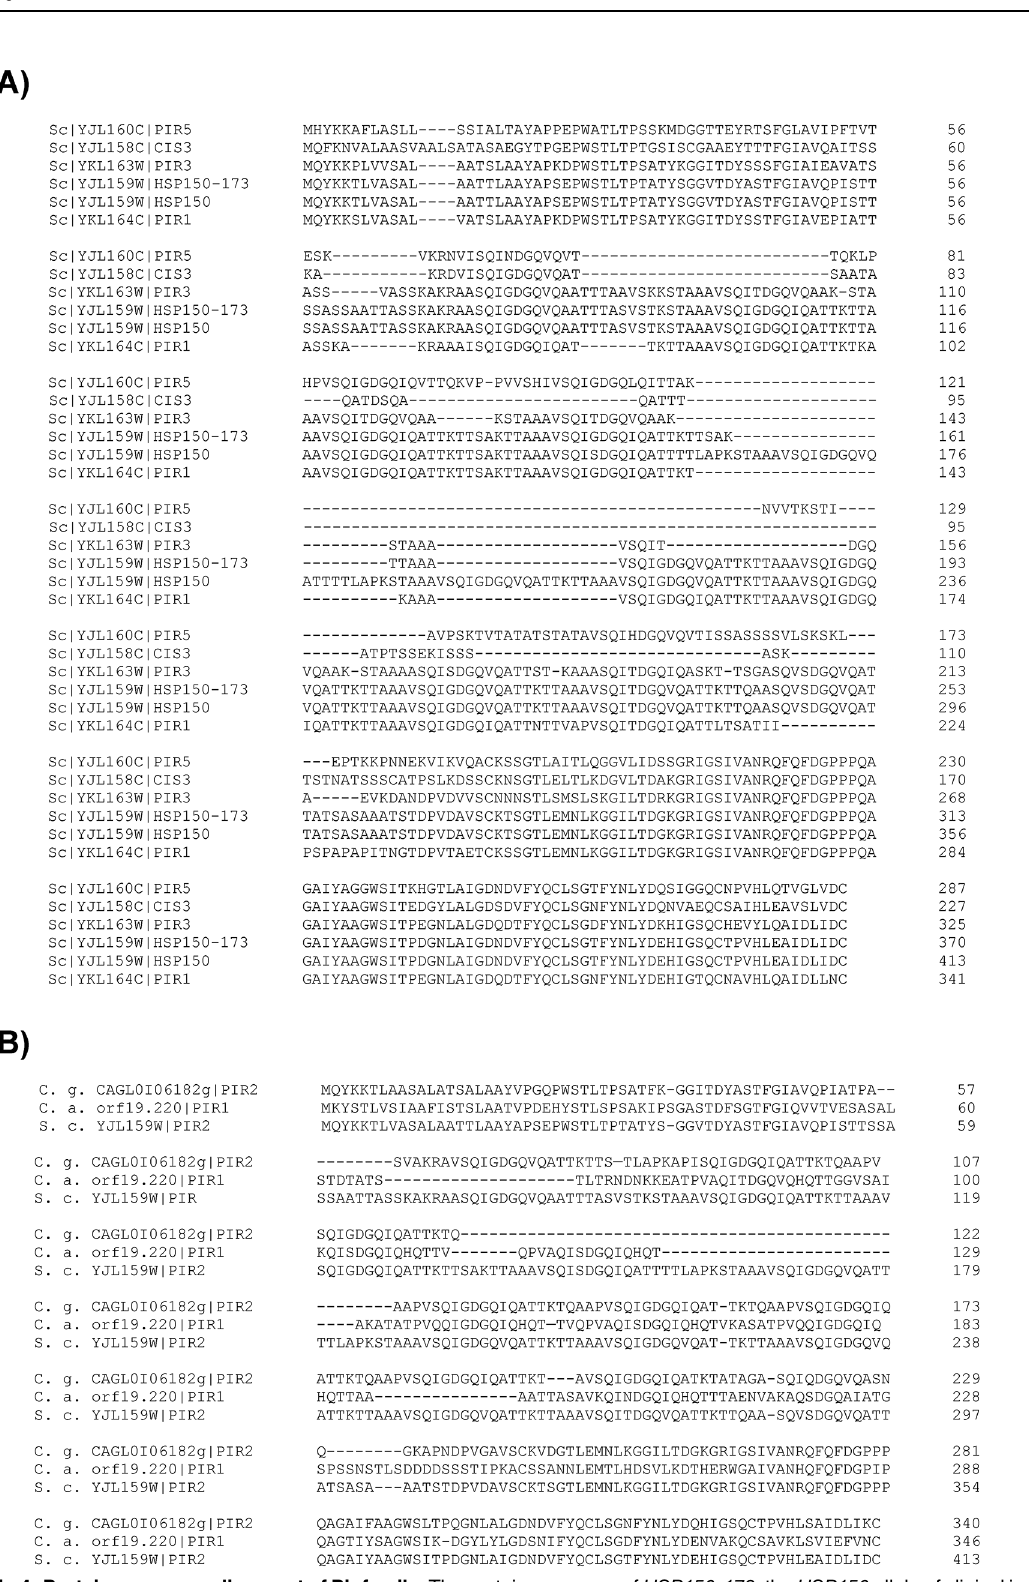
PLOS ONE | DOI:10.1371/journal.pone.0135174 August 13,